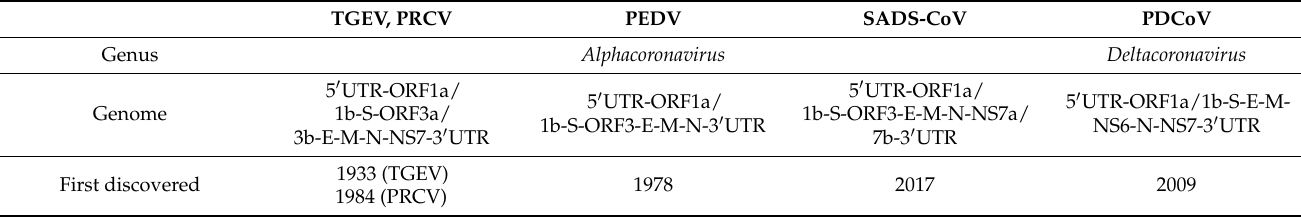
Table 1. Information on